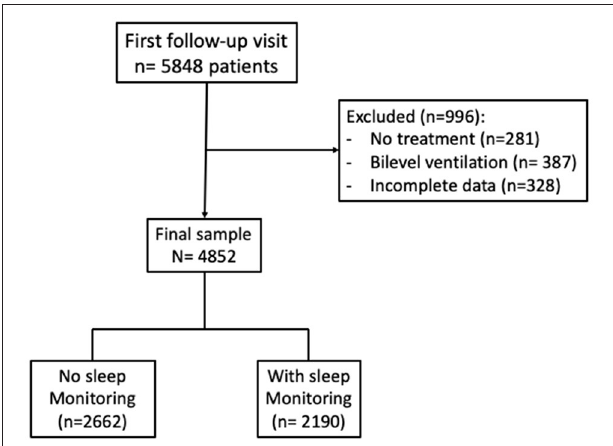
FIGURE 1 | Flow-chart of the study.